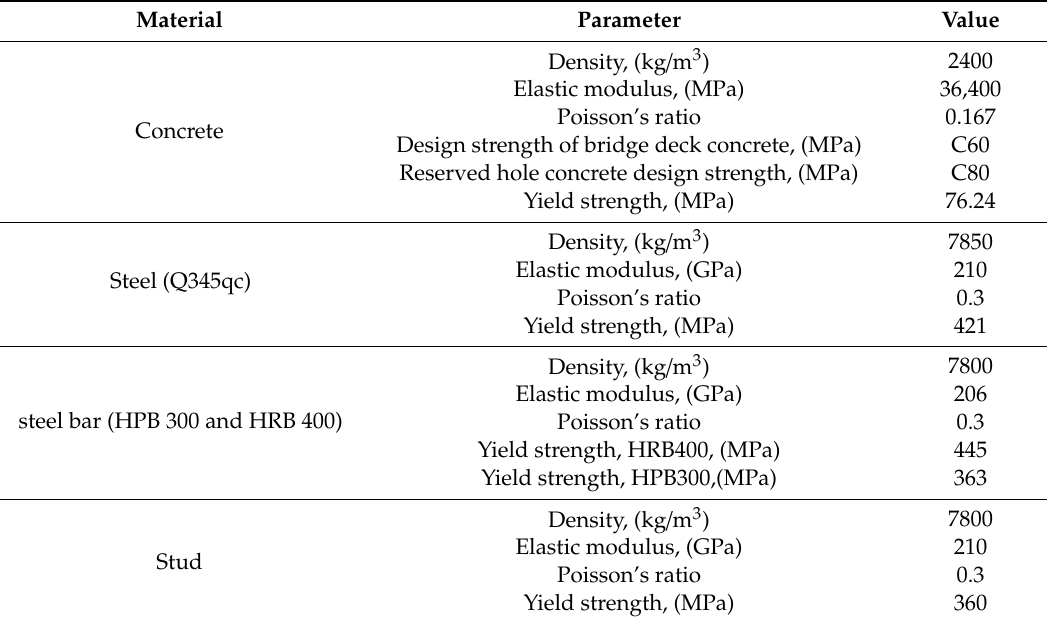
Table 1. Material details of experimental